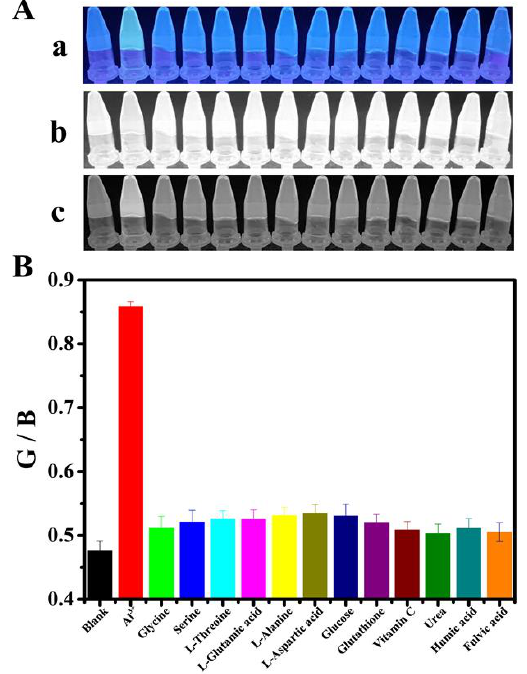
Figure 7. The selectivity of the RGB method towards various small molecules. ( a ) Images of the CDs-small molecule solution obtained with a smartphone under a 360 nm UV lamp, ( b ) blue channel and ( c ) green channel content of the image ( A ). ( B ) G/B value responses to the different small molecule (307.69 μM glycine, serine, L-threoine, L-glutamic, L-alanine, L-aspartic, glucose, glutathione, vitamin C, urea, and fulvic acid and 247 μg/mL humic acid).